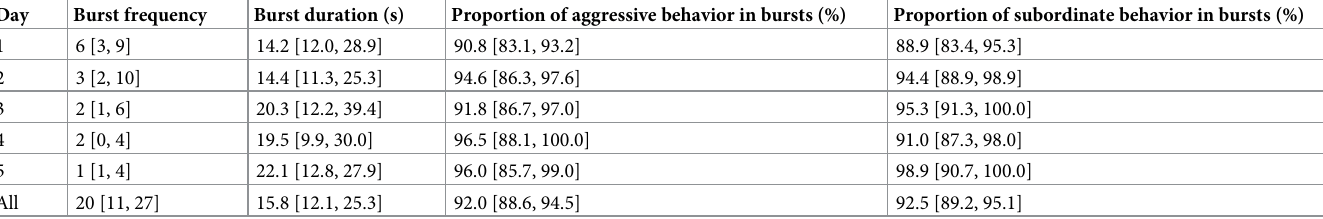
Table 2. Descriptive statistics of aggressive and subordinate behavior by day (medians and